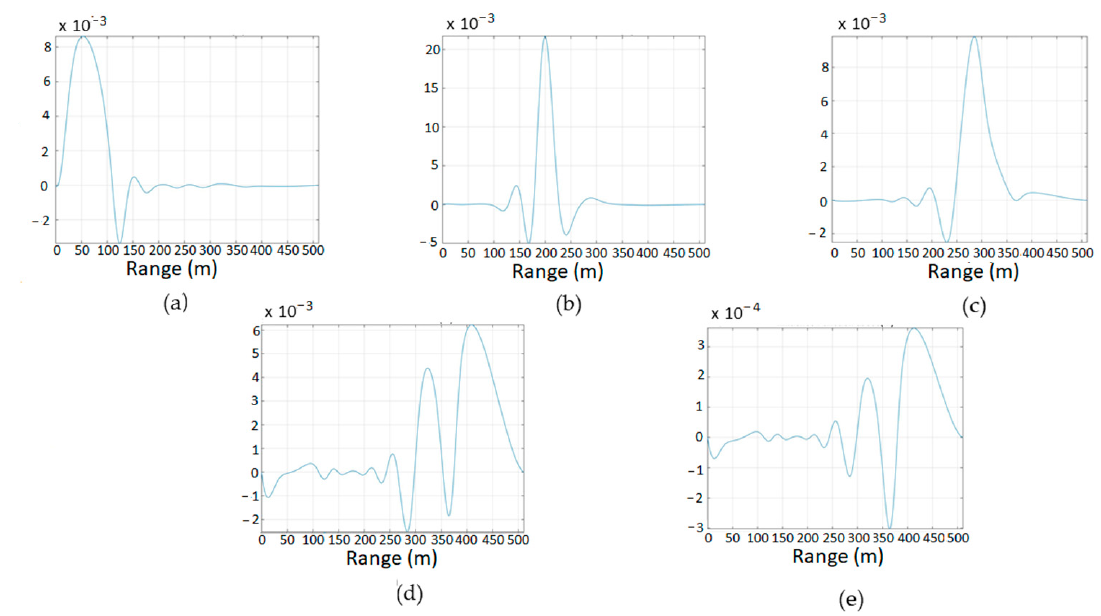
Figure 3. Influence functions at 5 different locations along the path. ( a ) At z = 50 m; ( b ) At z = 200 m; ( c ) At z = 300 m; ( d ) At z = 400 m; ( e ) At z = 500 m.